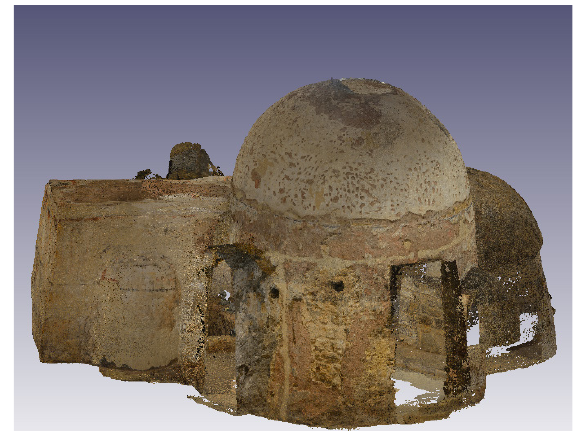
Figure 13. Photogrammetric point cloud of the “Sybil hypogeum”.